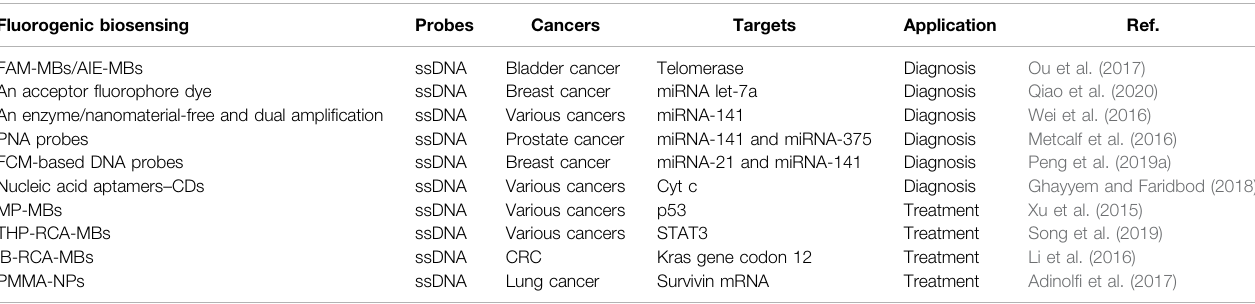
TABLE 1 | Application of nucleic acid probe – based fl uorescent sensing in cancer diagnosis and treatment. Fluorogenic